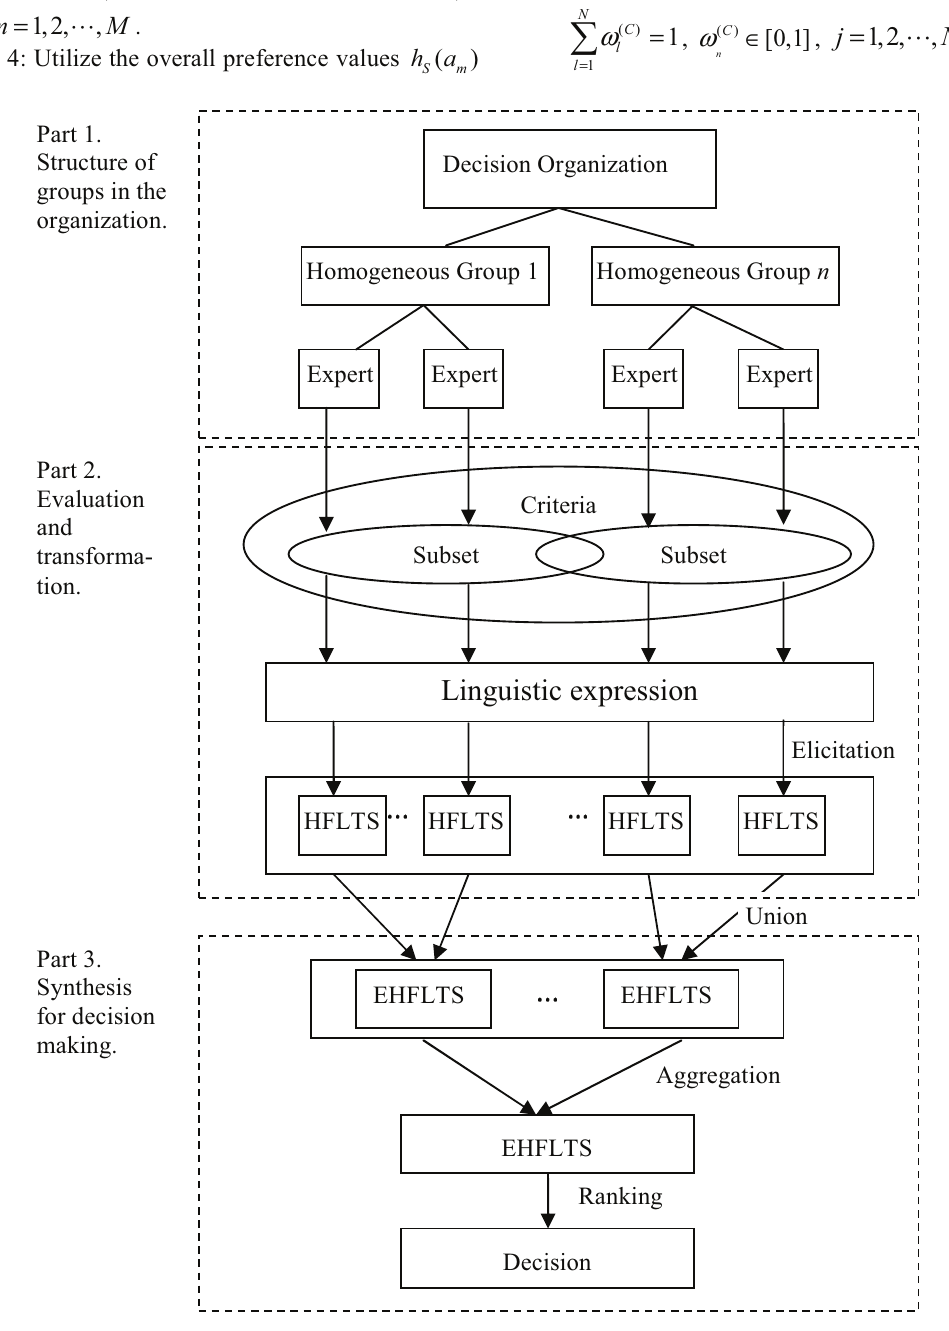
Fig. 3. Schema of the linguistic group decision making